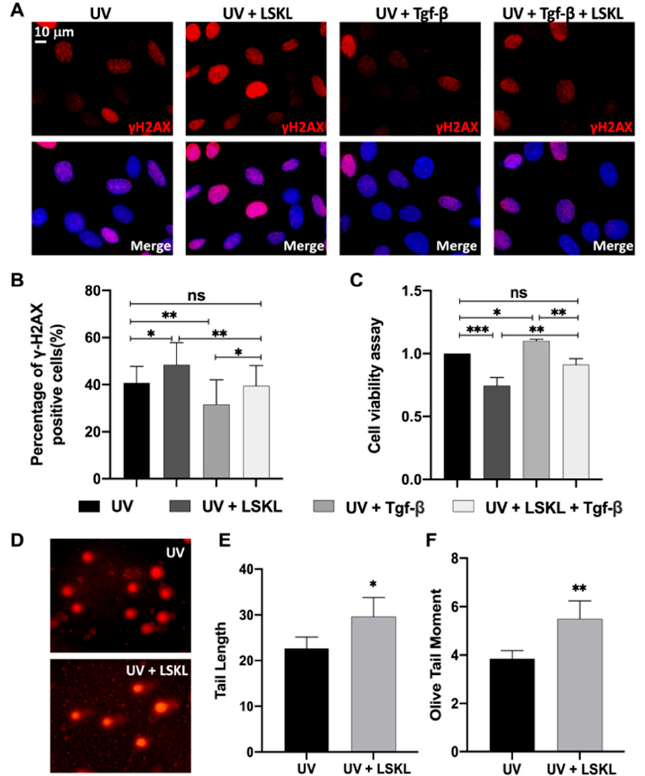
Figure 1. Tgf- β promoted DNA repair and cell viability in 661W cells. 661W cells were pretreated with LSKL (24 h), Tgf- β (1 h), both LSKL and Tgf- β or the control vehicle and exposed to UV irradiation. ( A ) The cells were then double-stained with γ -H2AX (red) and DAPI (blue). Scale bars: 10 µ m. ( B ) The percentage of γ -H2AX-positive 661W cells was increased in the UV + LSKL group, decreased in the UV + Tgf- β group compared to the vehicle control and returned to the control level in the UV + LSKL + Tgf- β group. ( C ) CCK8 assay showed that the cell viability of 661W cells was markedly impaired by LSKL pretreatment, elevated by Tgf- β pretreatment and returned to control levels when treated with LSKL and Tgf- β together. ( D ) The alkaline comet assay was used to detect the level of DNA damage in 661W cells. The tail length ( E ) and the olive tail moment ( F ) were significantly upregulated by LSKL pretreatment. Data are presented as the mean ± SD from 3 independent experiments. * p < 0.05, * * p < 0.01, *** p < 0.001. Ns, no